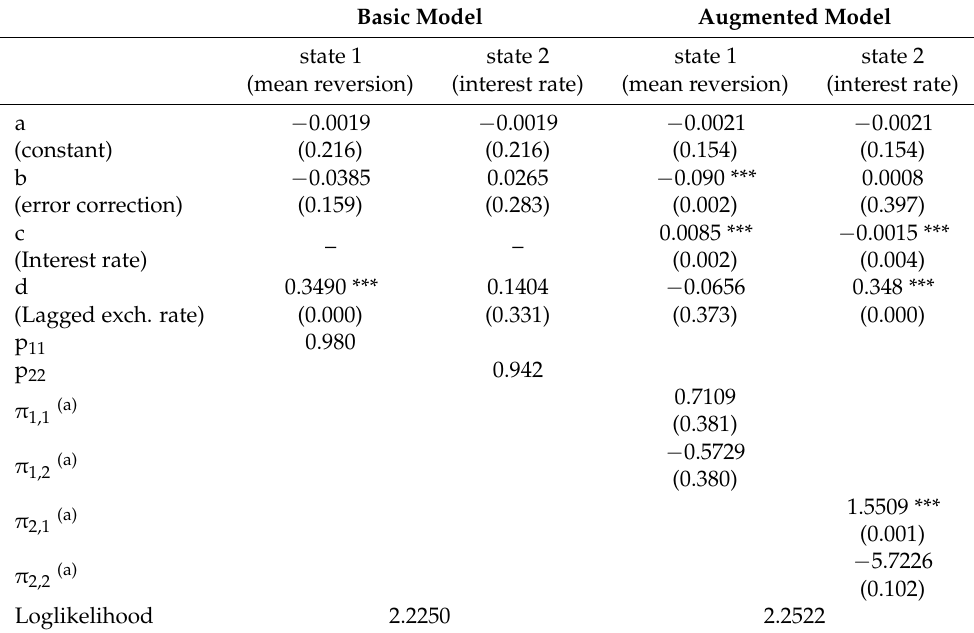
Table 2. Estimation results of the Markov switching